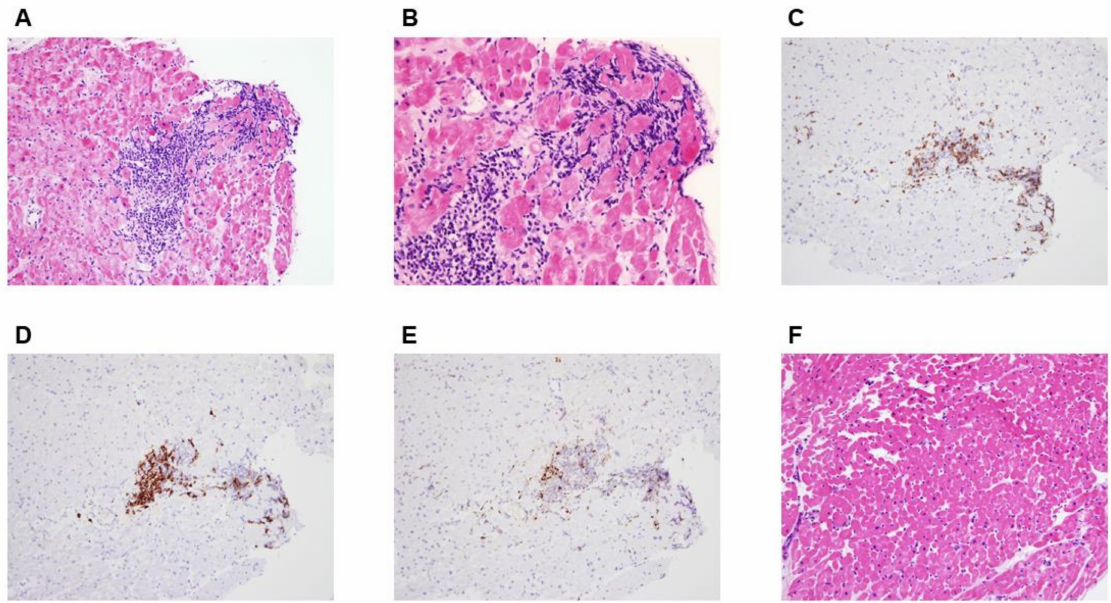
Figure 3. Histopathological Findings from Endomyocardial Biopsies. Hematoxylin-eosin stains of heart-tissue specimens showed inflammatory infiltrates composed of mononuclear cells with foci of severe interstitial edema and multifocal cardiomyocyte damage consistent with the diagnosis of definitive acute myocarditis (Panels A and B ). Immunostaining demonstrated predominant inflam- matory infiltration of lymphocytes (Panel C , CD3 immunostaining for T-lymphocytes, and Panel D , CD20 immunostaining for B-lymphocytes) and, to a lesser extent, macrophages (Panel E , CD68 immunostaining). A repeated endomyocardial biopsy 3 months later showed a complete resolution of myocarditis without evidence of inflammation or cardiomyocyte damage (Panel F , hematoxylin- eosin stains). Original magnification, × 200; scale bars, 100 µ m (Panels A , and D – F ) and original magnification, × 400; scale bars, 50 µ m (Panel